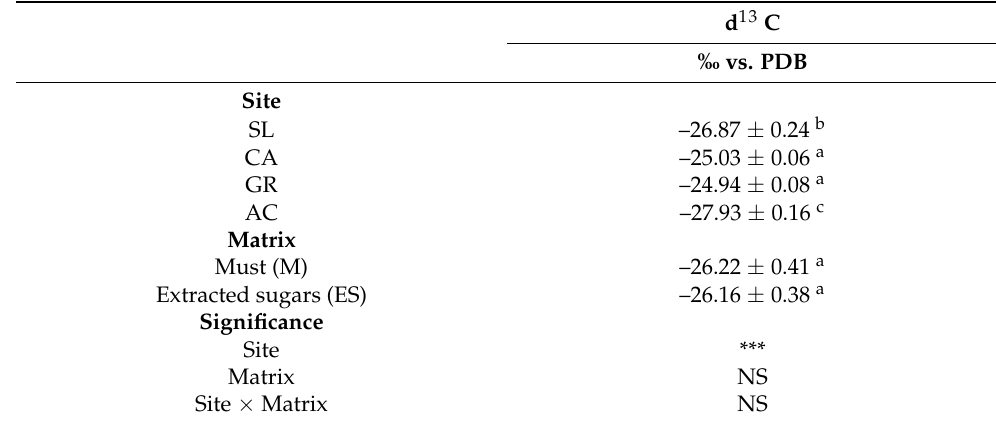
Table 2. Results of the two-way-ANOVA of δ 13 C values (‰ vs. PDB), using the matrix (must and sugars) and vineyards (SL, Santa Lucia; CA, Calvese; GR, Grottole; AC, Acquefredde) as factors. Mean values and standard errors are shown. Different letters correspond to significant